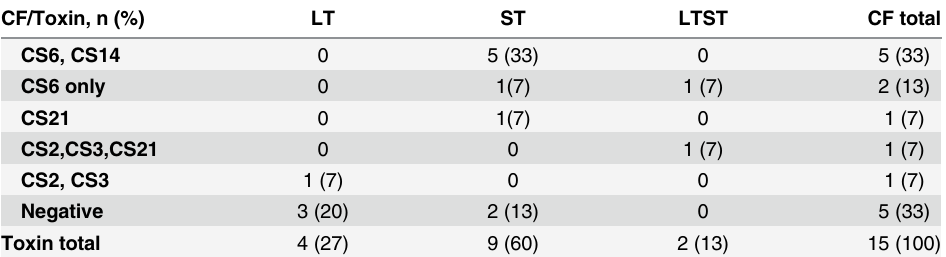
Table 5. Toxin and colonization factor distribution of Enterotoxigenic E . coli by PCR.